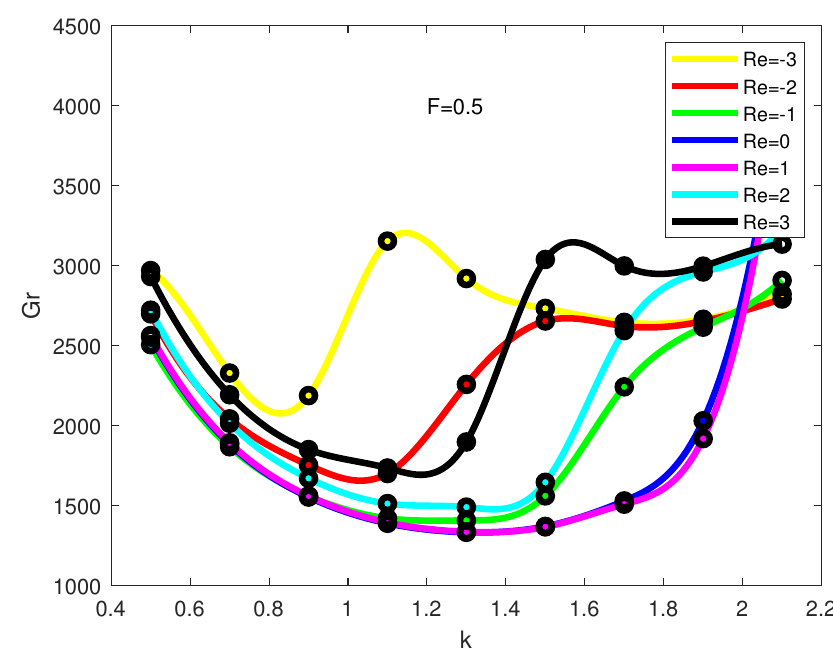
Figure 6. Marginal stability curves for F = 0.5 and η = 0.7 (the Reynolds number is in the range − 3 ≤ Re ≤ 3).